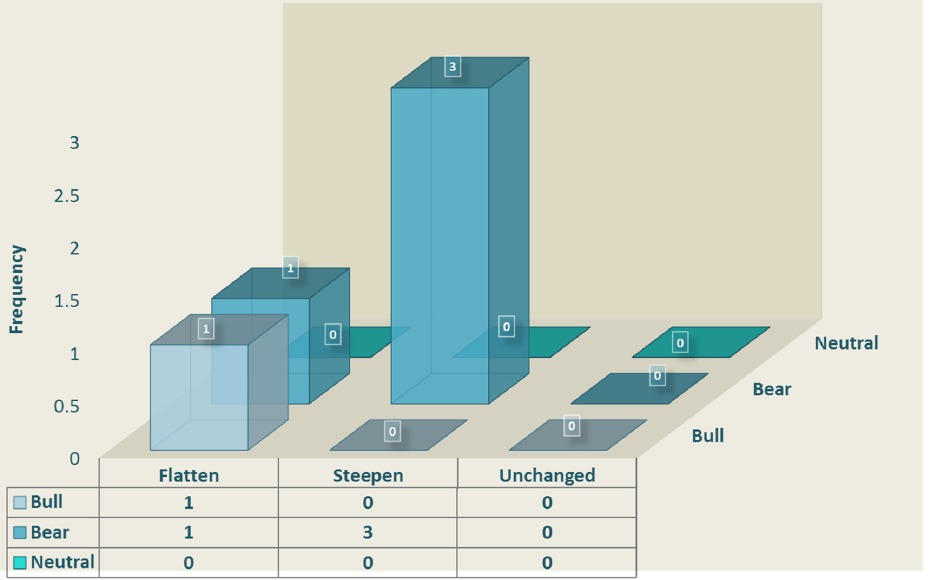
Figure 11. Weekly yield curve patterns on 25 March 2022 (last 5 weeks). Source: Bloomberg yields, own computation of yield curve patterns.